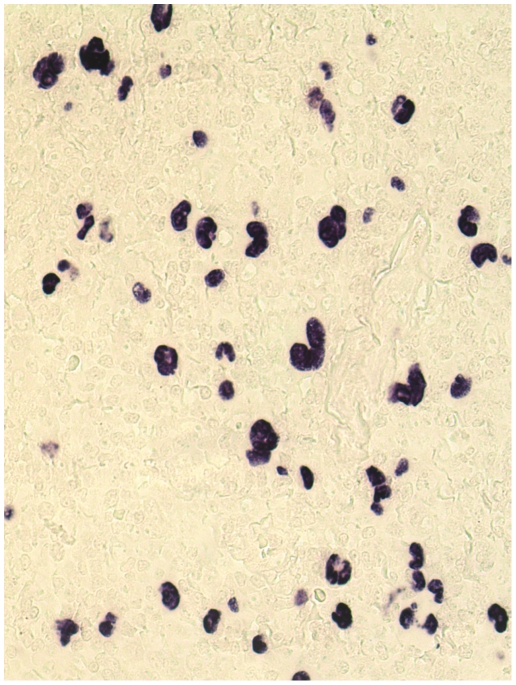

In situ hybridization (ISH) for EBERs in an EBV+ cHL case.The EBER-ISH revealed a homogeneous positive signal in the nucleus of all Hodgkin and Reed–Sternberg (HRS) cells as well as in some small reactive cells (original magnification ×40).